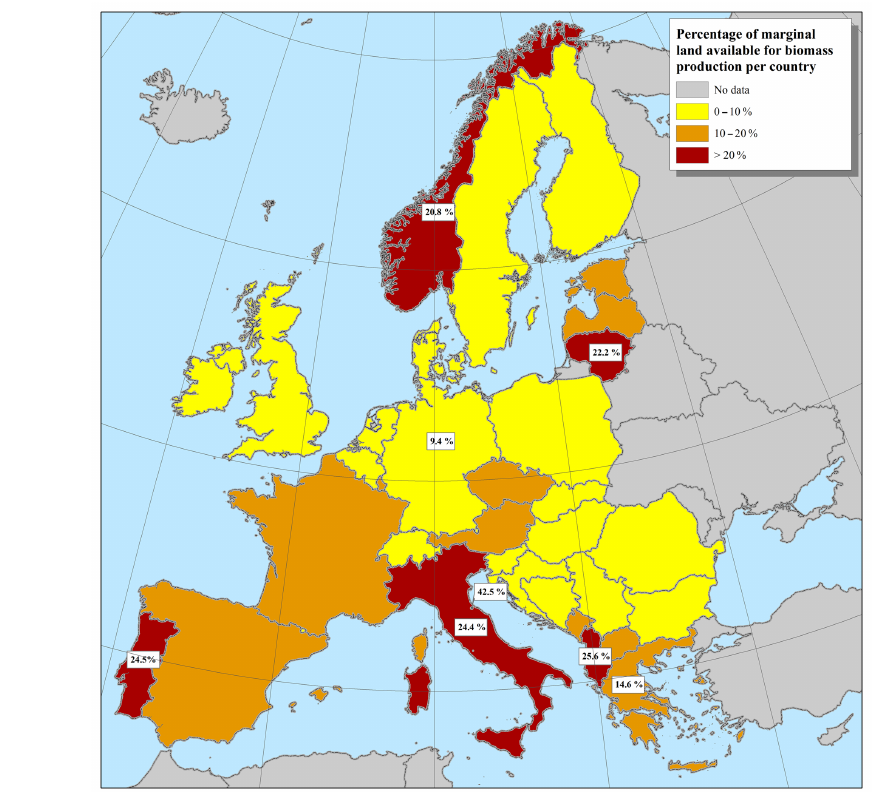
Figure 9. Percentage of marginal land available for biomass exploitation per country.